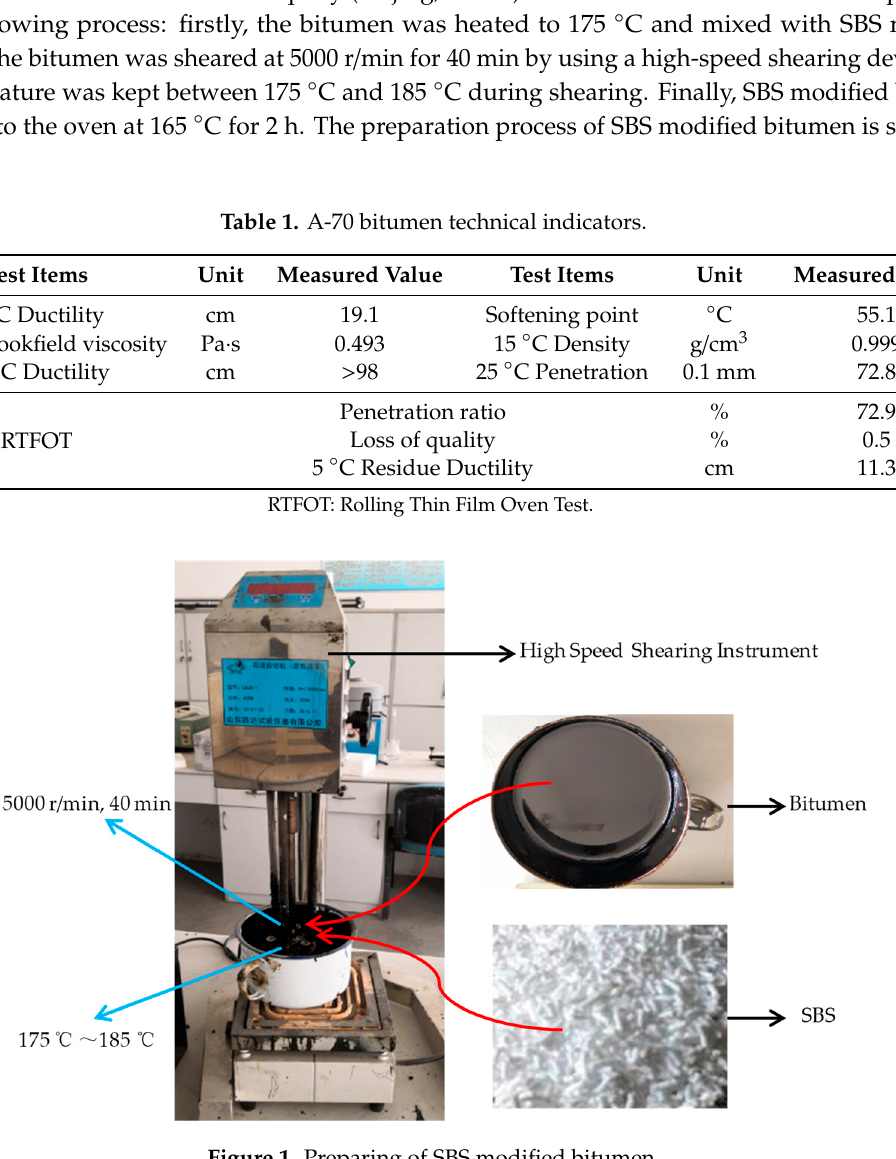
Figure 1. Preparing of SBS modified bitumen.